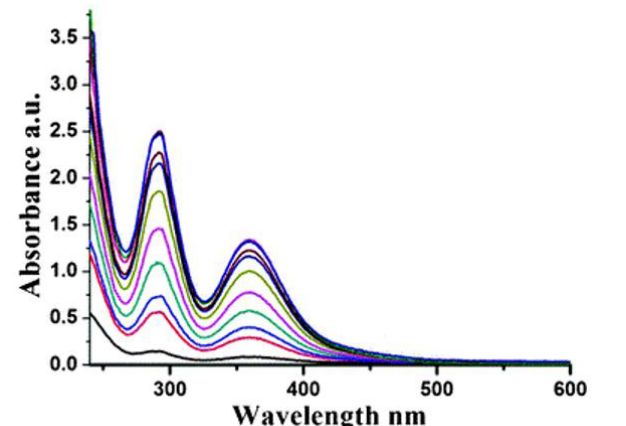
Fig. 4. Absorption spectrum of CdO nanoparticles with various aryl mercaptanes during 90 (s) (concentration of CdNPs is equal to 250 ppm and 2.5 ml used, phenyl mercaptan 60 nmol, phenyl mercaptan 45.5 nmol and phenyl mercaptan 55.5 nmol). The optical difference for aggregation of aryl mercaptanes connected to chains with various lengths to CdO nanoparticles can be attributed to size of aggregation linked to DNA/RNA and inter–particle